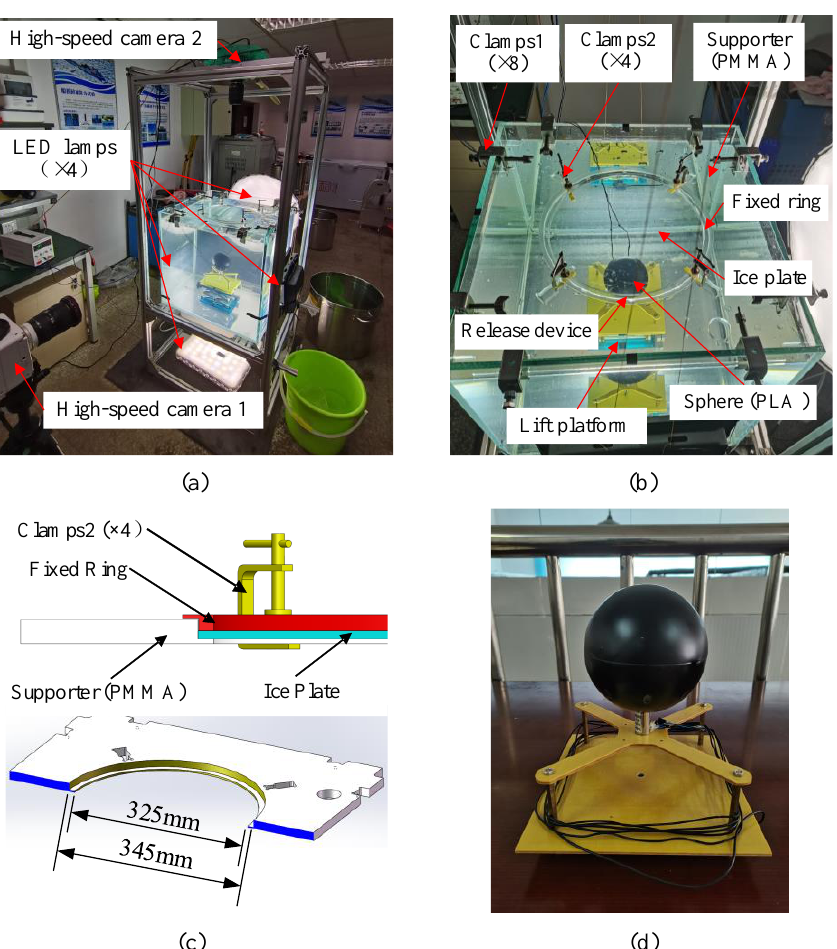
Figure 5. Experimental setup: ( a ) supporting system and camera system; ( b ) ice-fixing system and sphere location and releasing system; ( c ) cross-section diagram of ice-fixing supporter and the fixation way of the ice plate; and ( d ) releasing device and the sphere.